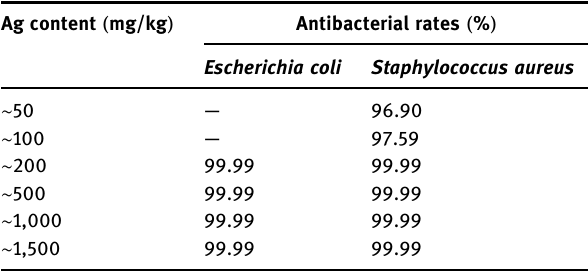
Table 2: Antibacterial rate of treated polyester fi bers after laun